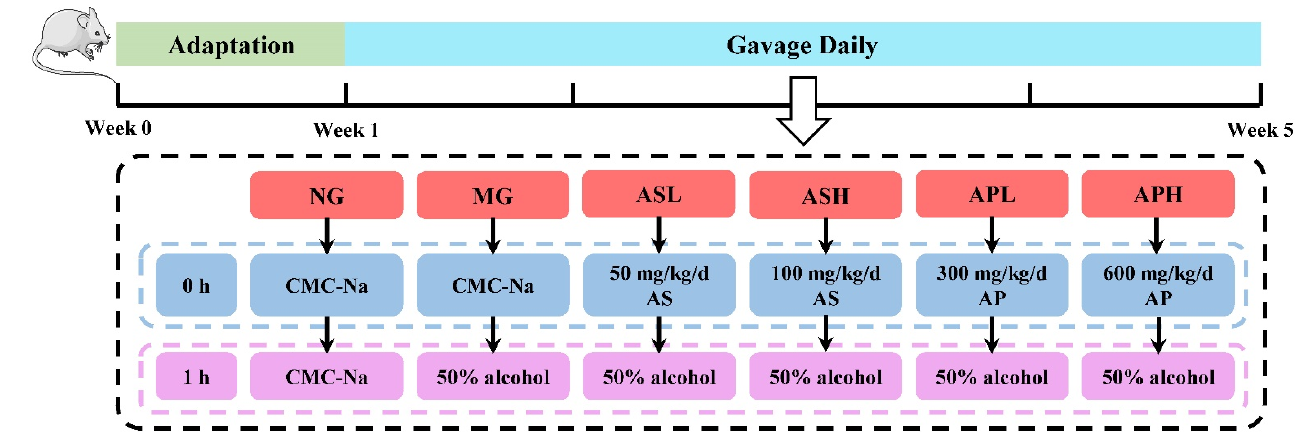
Figure 1. Schematic diagram of the whole animal experimental process